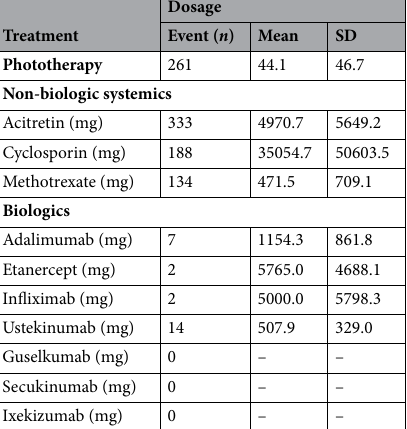
Dosage Event ( n ) Mean